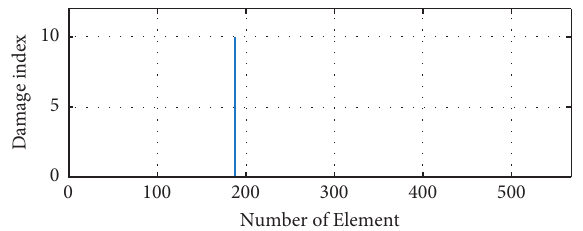
Figure 30: Results of single-damage case D1 using MCA-DI (building with the unsymmetrical distribution of columns).